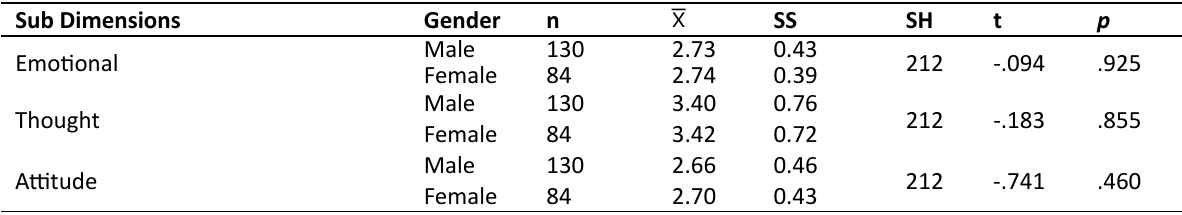
Table 1. Independent T Test Results by Gender Variable Sub